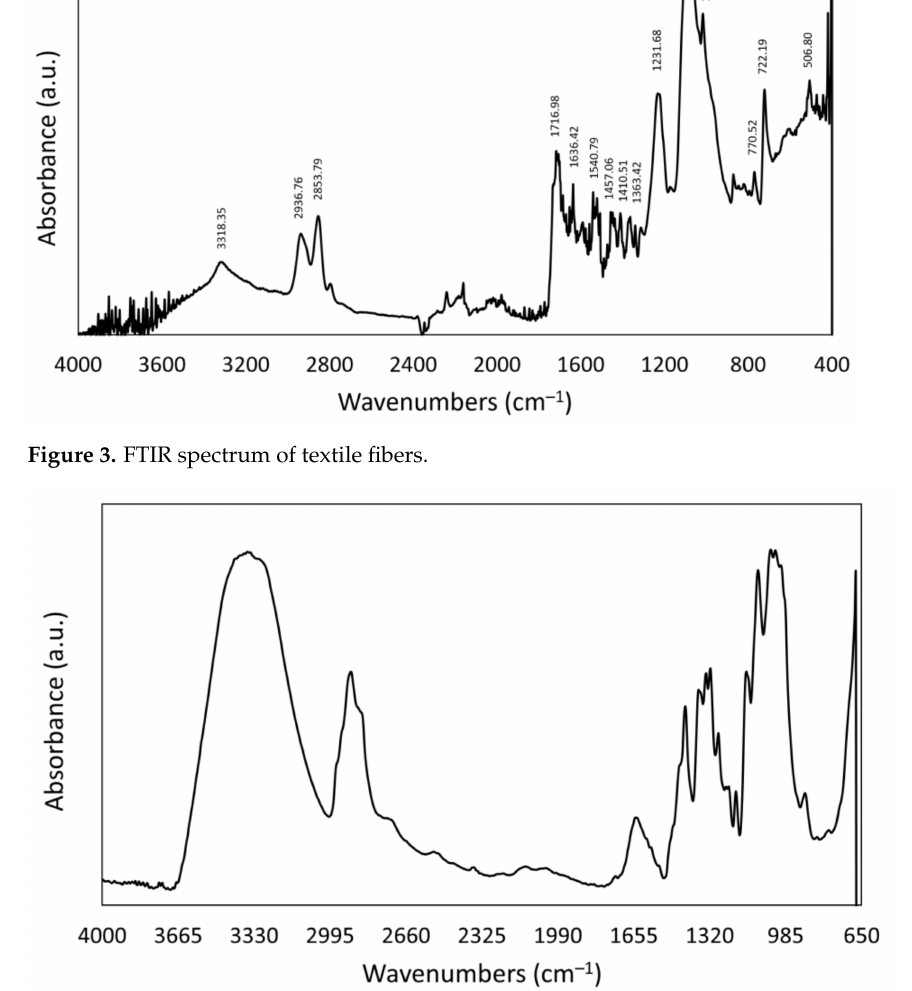
Figure 4. Representative FTIR spectrum of complex textile fibers (a total of 20 randomly selected fibers were analyzed).